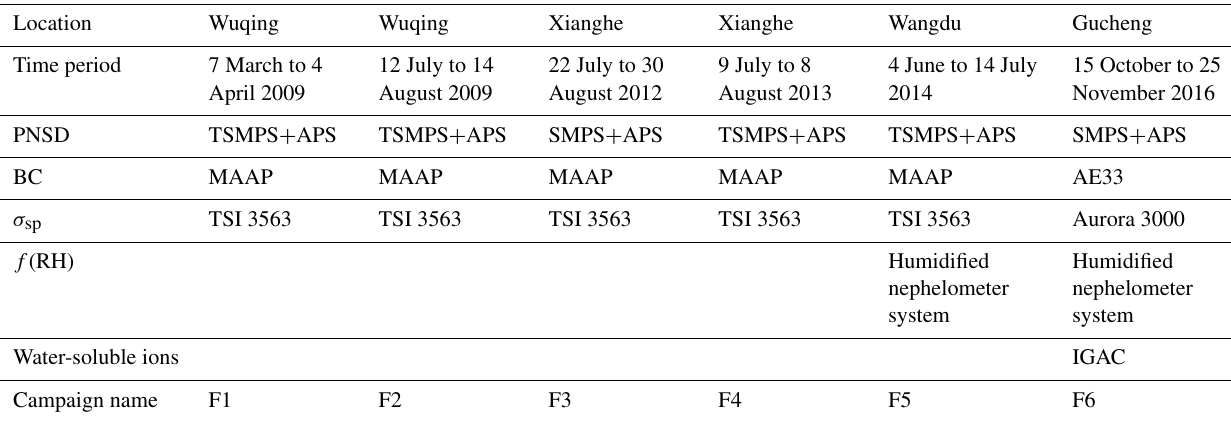
Table 1. Locations, time periods and used datasets of six field campaigns.